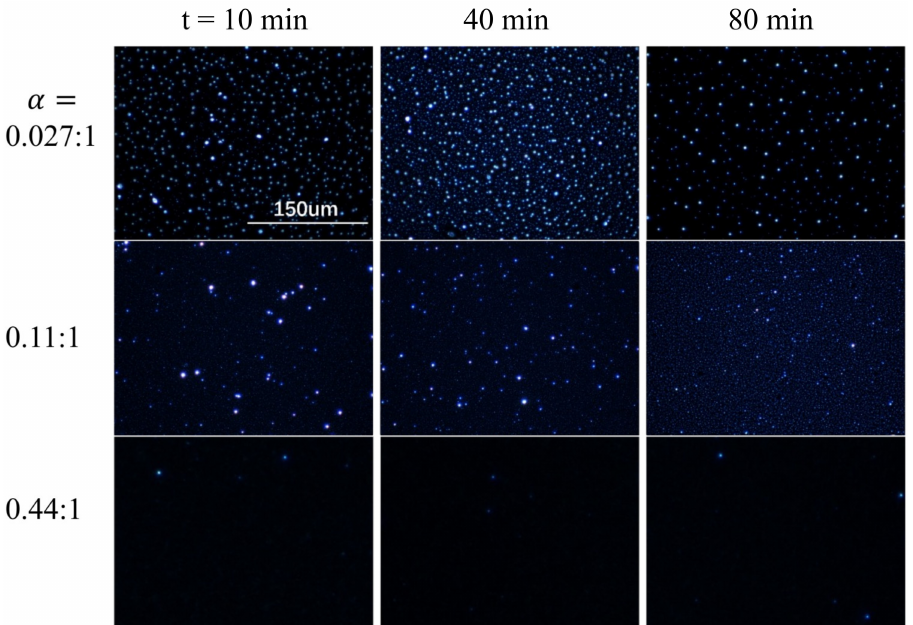
Figure 5. Dark field microscope images of gel layers with different alpha values after different annealing times.